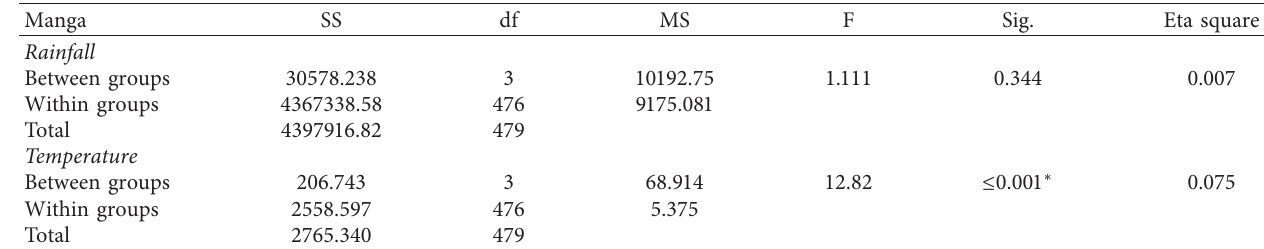
Table 9: ANOVA test statistics, Manga.